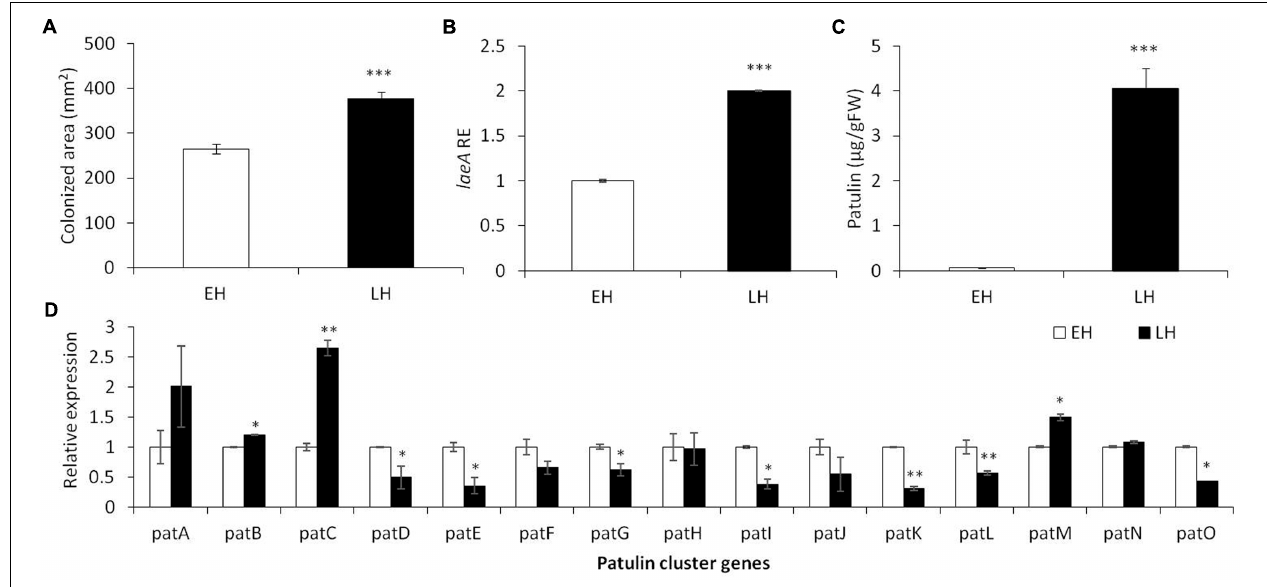
FIGURE 1 | Effect of early (EH) and late harvested (LH) apple fruit on the relative expression of laeA and patulin cluster, patulin accumulation and colonized surface following the inoculation of Penicillium expansum in Golden Delicious fruits. Apple fruits cv. Golden Delicious were harvested first 135 days after fruit set (early harvest) and 156 days after fruit set (late harvest) and inoculated immediately. Five days later the colonization pattern (A) , laeA relative expression (B) , patulin accumulation in the colonized tissue (C) , and the relative expression of the pat cluster genes (PCG) (D) was evaluated. RNA was prepared from the leading edge of the colonized area. Average values ( ± SE) of five replicates are reported. For statistical analysis, the unpaired student t -test was used with significance defined as a P value ( ∗ P ≤ 0.05; ∗∗ P ≤ 0.01; ∗∗∗ P ≤ 0.001).